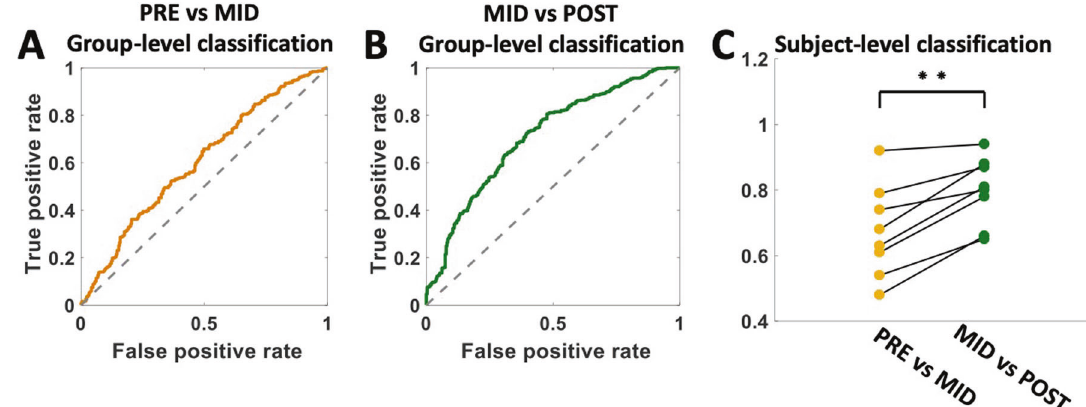
Fig. 4 Classi fi cation analysis to specify the stimulation protocol to enhance acute intraoperative electrophysiological change. A Group- level logistic regression classi fi ers with elastic-net regularization failed to discriminate above chance between pre-stimulation baseline (PRE) and mid-procedure (MID) LFPs, AUC mean = 0.574; SD = 0.04, N = 7 mid-procedure samples (MID) followed non-speci fi c, unilateral testing at all contacts, including tractography-de fi ned non-optimal contacts. B Group-level logistic regression classi fi ers reliably discriminated MID from post-stimulation (POST) LFP samples, where POST recording followed exposure to bilateral stimulation at the tractography-de fi ned “ optimal ” contacts, AUC MEAN = 0.684; SD = 0.059, N = 7. C Patient-level logistic regression classi fi er performance improved following exposure to tractography-de fi ned “ optimal ” stimulation ( p <